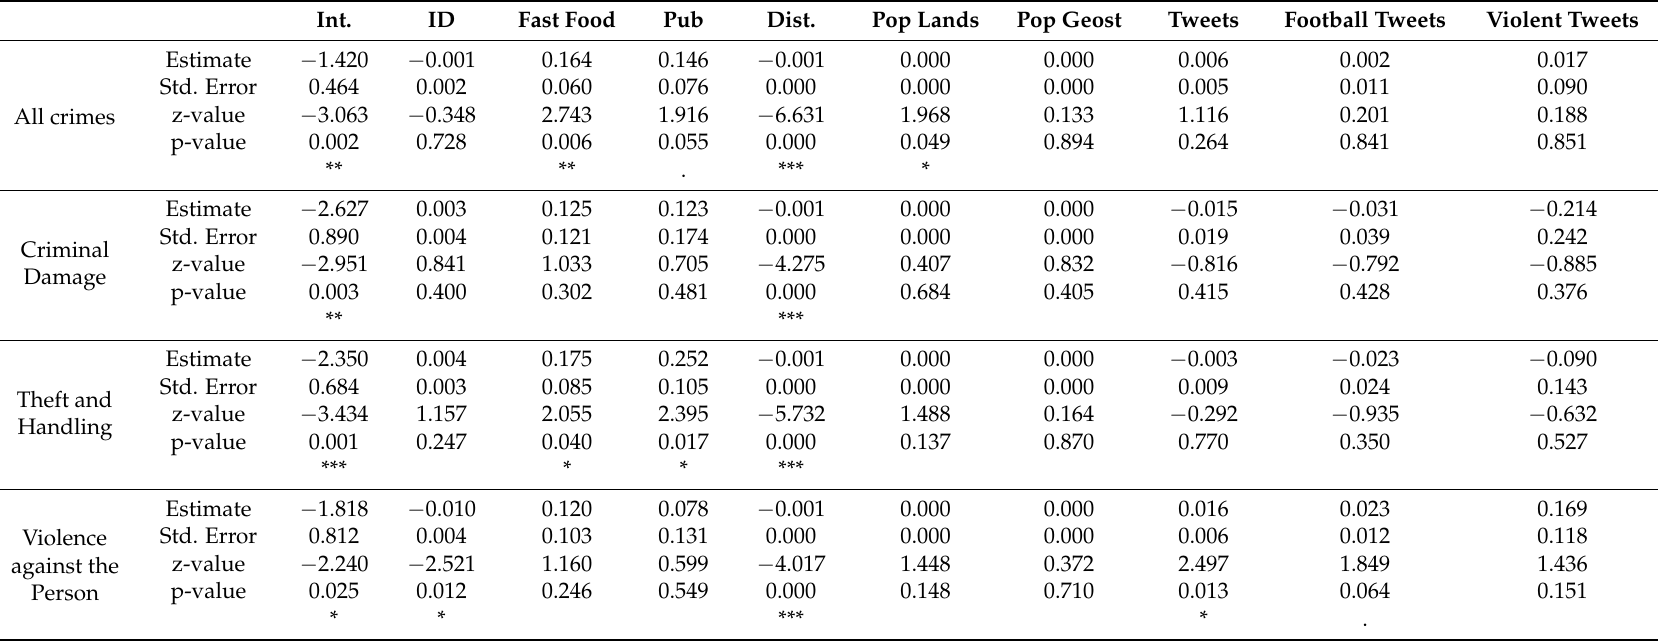
Table 6. NBLR models coefficients (p = 0 '***' 0.001 '**' 0.01 '*' 0.05 '.'